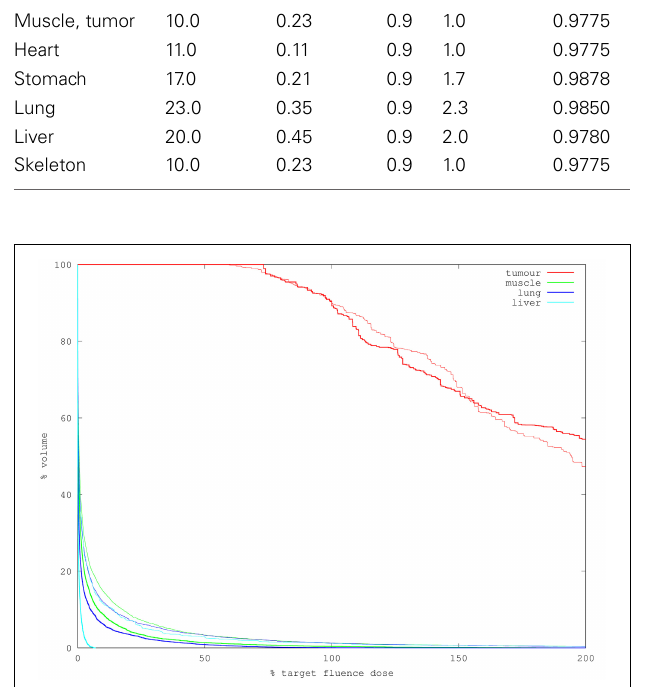
FIGURE 3 | DVH for two treatment plans using 10M packets to simulate (2 min runtime each). Bold lines indicate the “good” plan in which the source is contained within the tumor; faint lines of matching color indicate the corresponding organ in the “bad” plan. Note the good plan treats more of the tumor to doses exceeding 90% of targe while delivering much less dose to the organs at